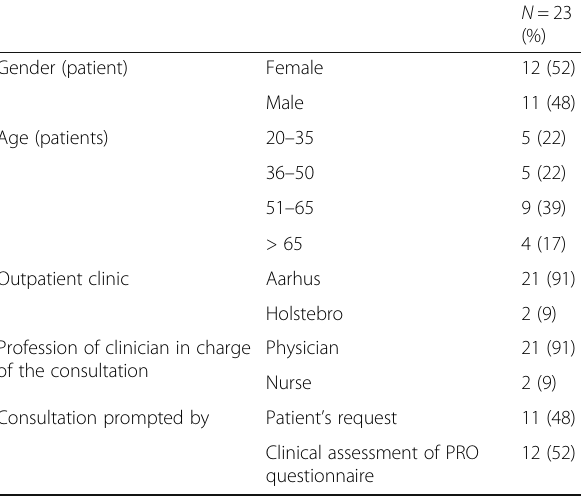
Table 1 Observations in PRO